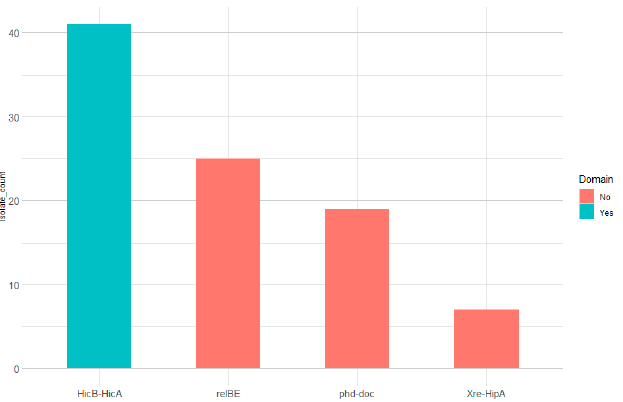
Figure 1. Isolate count per toxin-antitoxin (TA) family type. Bar lengths correspond to the number of isolates containing TA systems belonging to a given TA family. Blue bars represent TA systems where both toxin and antitoxin genes harbor a TA-related domain, while red bars represent TA systems where either the toxin or antitoxin gene harbor a TA-related domain. Next, the distribution of toxin-antitoxin genes across isolates as a function of the isolate source and clonal complex was investigated. We wanted to check if isolates that are sampled from the same animal/clinical source or share the same clonal complex also share the same toxin-antitoxin genes. The distribution of TA genes was found to be highly sparse as a function of the isolate source (Figure 2A). On the other hand, the same distribution appears to be less sparse as a function of the clonal complex (Figure 2B). To further investigate whether the isolate source or clonal complex are dependent on the presence of different TA families, a Pearson chi-square test of independence between each clonal complex/isolate source and family pair were performed. According to both the chi-square and Fisher test, no significant association between the isolate source and family type was found, suggesting that the isolate source and TA family type are independent of each other. In contrast, there was a strong association between four CCs and three TA family types confirmed through Fisher’s exact test (Supplementary File S5), suggesting a dependent relationship between some TA family types and certain clonal complexes (Figure 2D). Since most of the identified TA systems are based on BLAST alignment against the TADB and PADS databases, and since contigs were assembled in isolates from different veterinary/clinical sources, it is highly plausible that the matched TA systems are found in different strains. Accordingly, we wanted to connect each TA system identified in each isolate to the genome where it was identified (Figures S3 and S4). In addition, we also checked the association between TA family types and the genomic strains where they were identified (Figure 3). Interestingly, we observed that most of HicB- HicA TA systems were identified from the C. jejuni 81-176 strain, while almost all the other families were identified from C. jejuni RM1221 (Figure S3). It is also worth noting that the HicB-HicA family was the only family identified that harbors a TA-related domain. (Figure 1). On the other hand, either the toxin or antitoxin in the other families contain a TA-related domain. This pattern can be seen in Figure S4, where only the TA systems that contain both the toxin and antitoxin domain are considered and showed the absence of connections from C. jejuni RM1221.